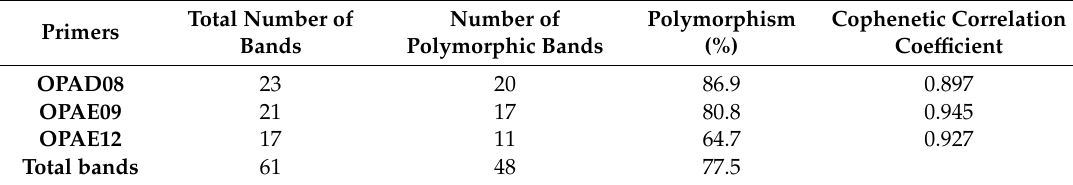
Table 1. Numbers and percentages of polymorphism of amplification products based on the different RAPD primers.